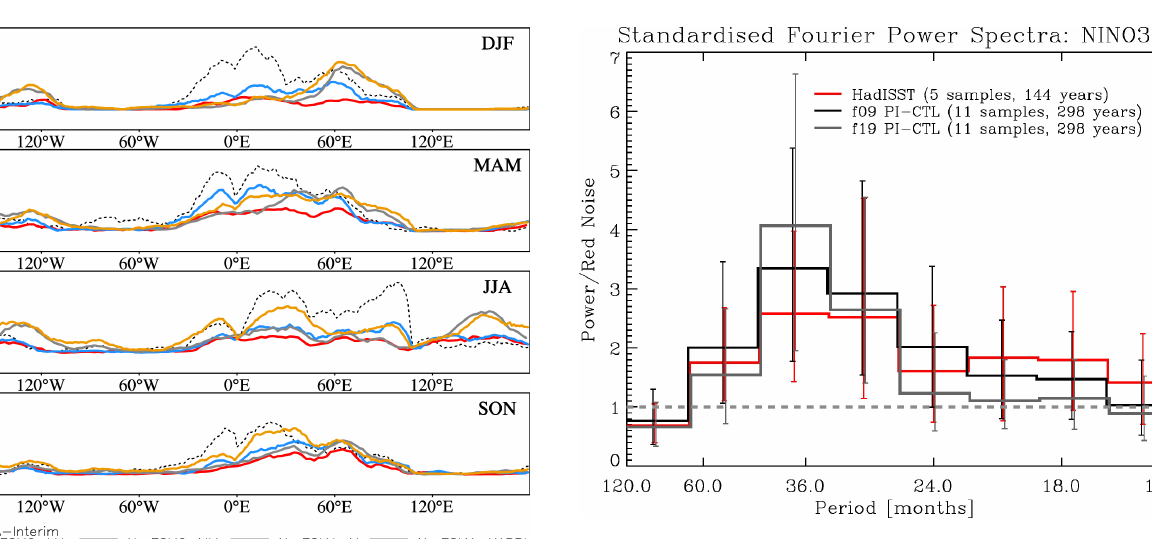
Figure 21. Frequency analysis of El Niño events in NorESM2-MM (f09) and NorESM2-LM (f19) and the Hadley Centre Sea Ice and Sea Surface Temperature dataset (HadISST) v1.1 (Rayner et al., 2003) observed data. Fourier power spectra of NINO3.4 anomalies, normalised to AR1 red-noise model for each (using bootstrapping, 1000